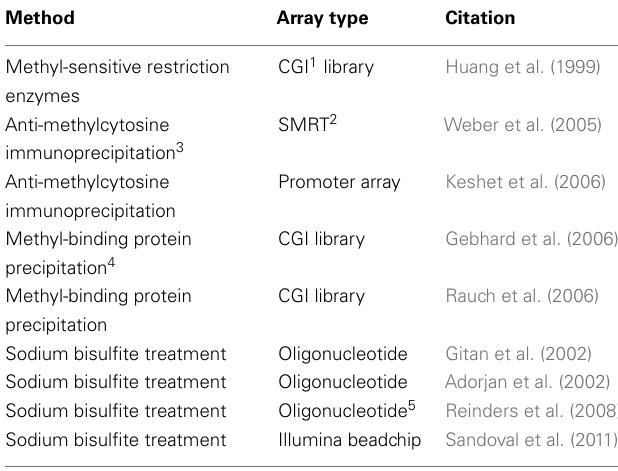
Table 4 |Applications of microarray technology to differential DNA methylation